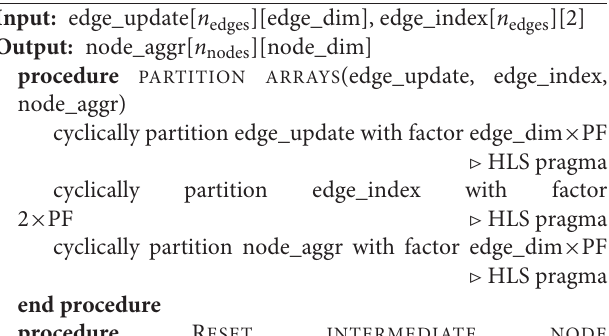
Algorithm 3 : Resource-optimized aggregation